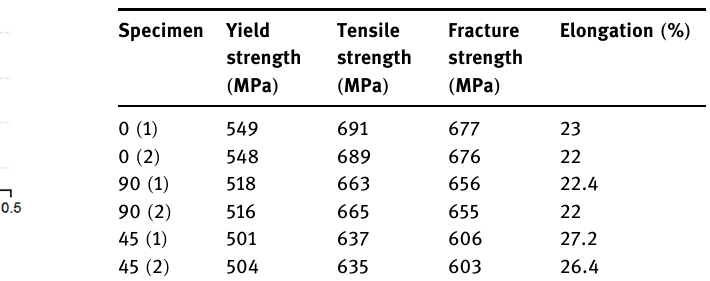
Table 3: Tensile test results for HSLA